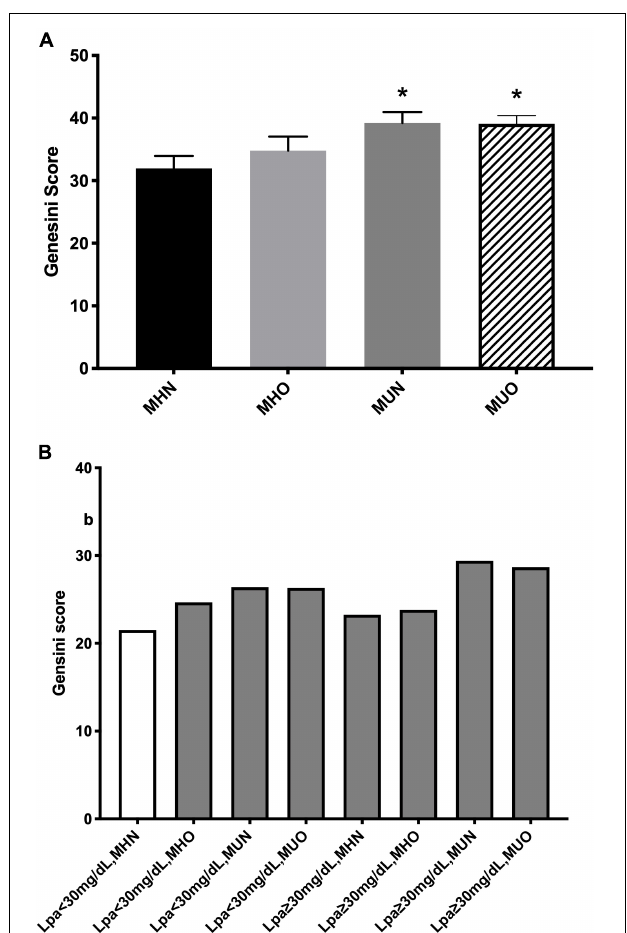
FIGURE 1 | Coronary severity according to (A) metabolic phenotype; and (B) both status of metabolic phenotype and lipoprotein(a) [Lp(a)]. * p <